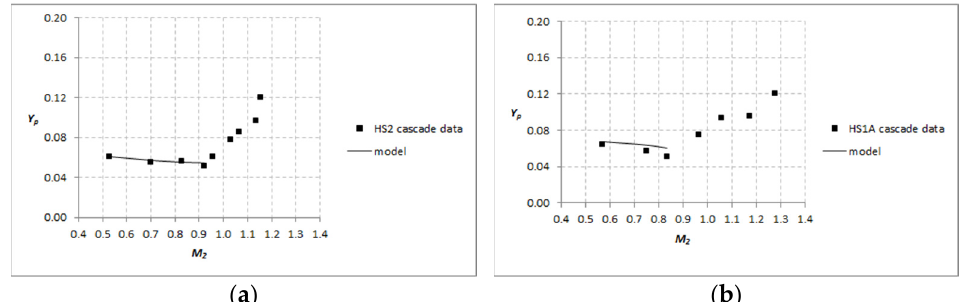
Figure 3. Comparison of simulated and experimental total pressure profile loss coefficient for ( a ) HS2 cascade [23]; ( b ) HS1A cascade [24].